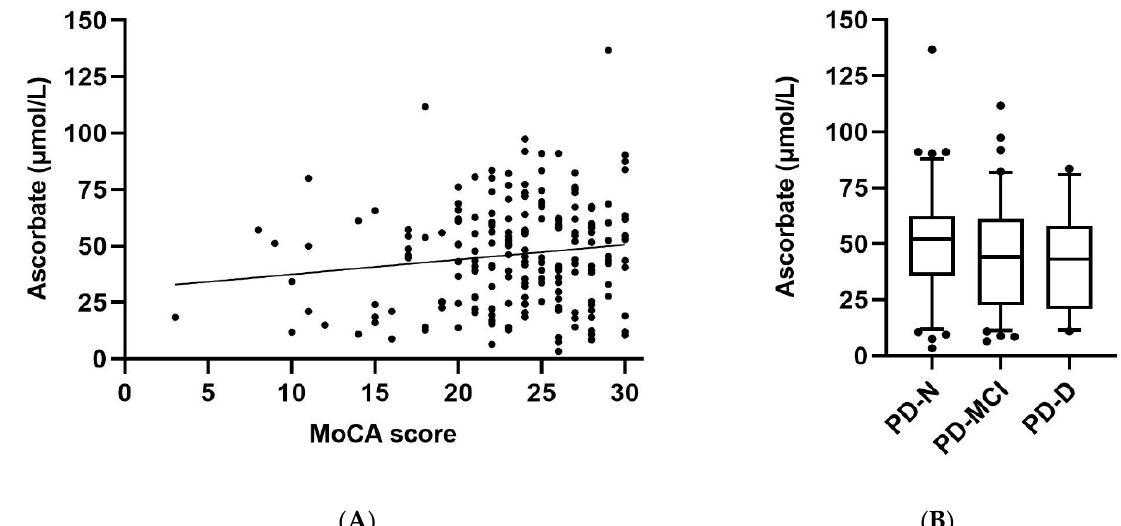
Figure 2. Plasma ascorbate concentrations relative to cognitive function. ( A ) MoCA (Montreal Cognitive Assessment) scores in the Parkinson’s disease group ( n = 212) showed a significant positive correlation with ascorbate status ( r = 0.14, p = 0.045). ( B ) Plasma ascorbate concentrations in individuals with Parkinson’s disease as per cognitive status subgroups: normal (PD-N, n = 95), mild cognitive impairment (PD-MCI, n = 84), and dementia (PD-D, n = 34); the cognitively impaired group (PD-MCI and PD-D combined, n = 118) was significantly lower than the PD-N group ( p = 0.03). Box plots show medians with boundaries set at 25th and 75th percentiles, whiskers at 5th and 95th percentiles, outliers are indicated by symbols.